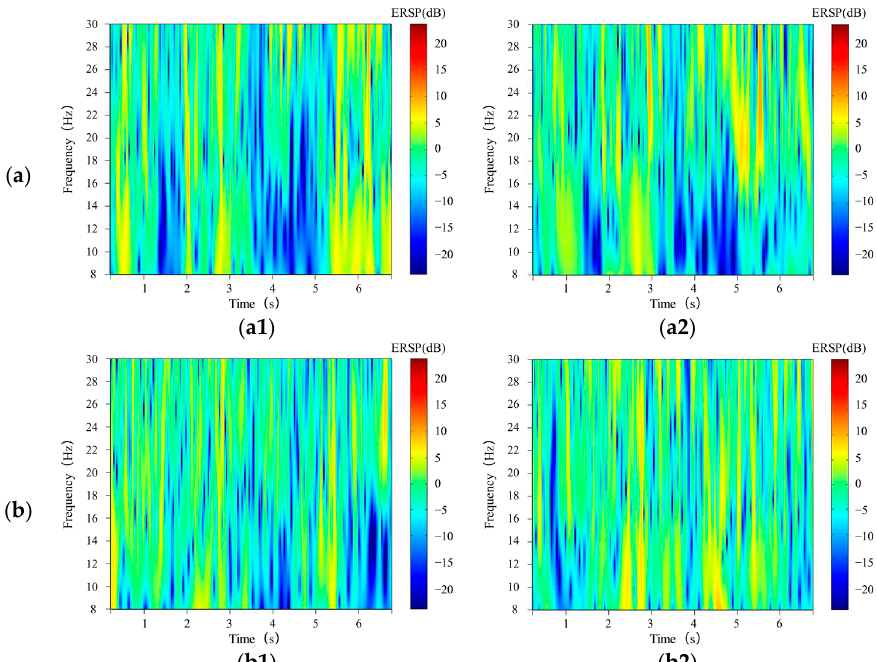
Figure 3. ( a ). Time-frequency images of the C3 ( a1 ) and C4 ( a2 ) channels when the subject performing the left-hand motor imagery. It can be seen that the energy of the C3 channel remains at a high level 4 s after the trail begins, while the C4 channel decreases significantly. ( b ). Time-frequency images of the C3 ( b1 ) and C4 ( b2 ) channels when the subject performing the right-hand motor